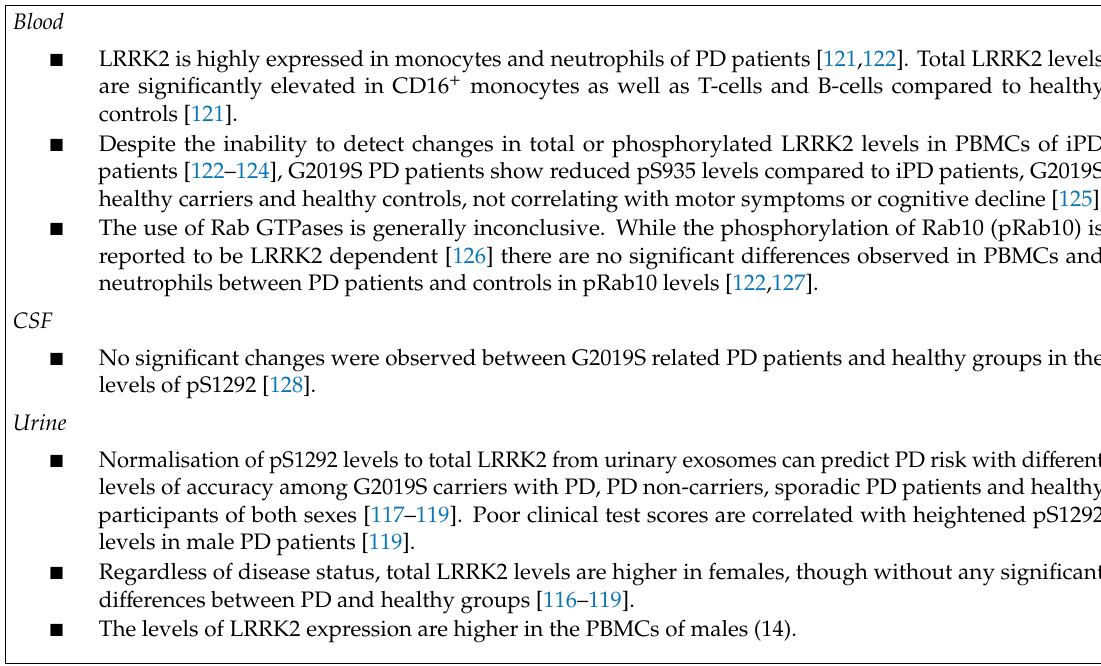
Box 2. Overview of LRRK2-targeted